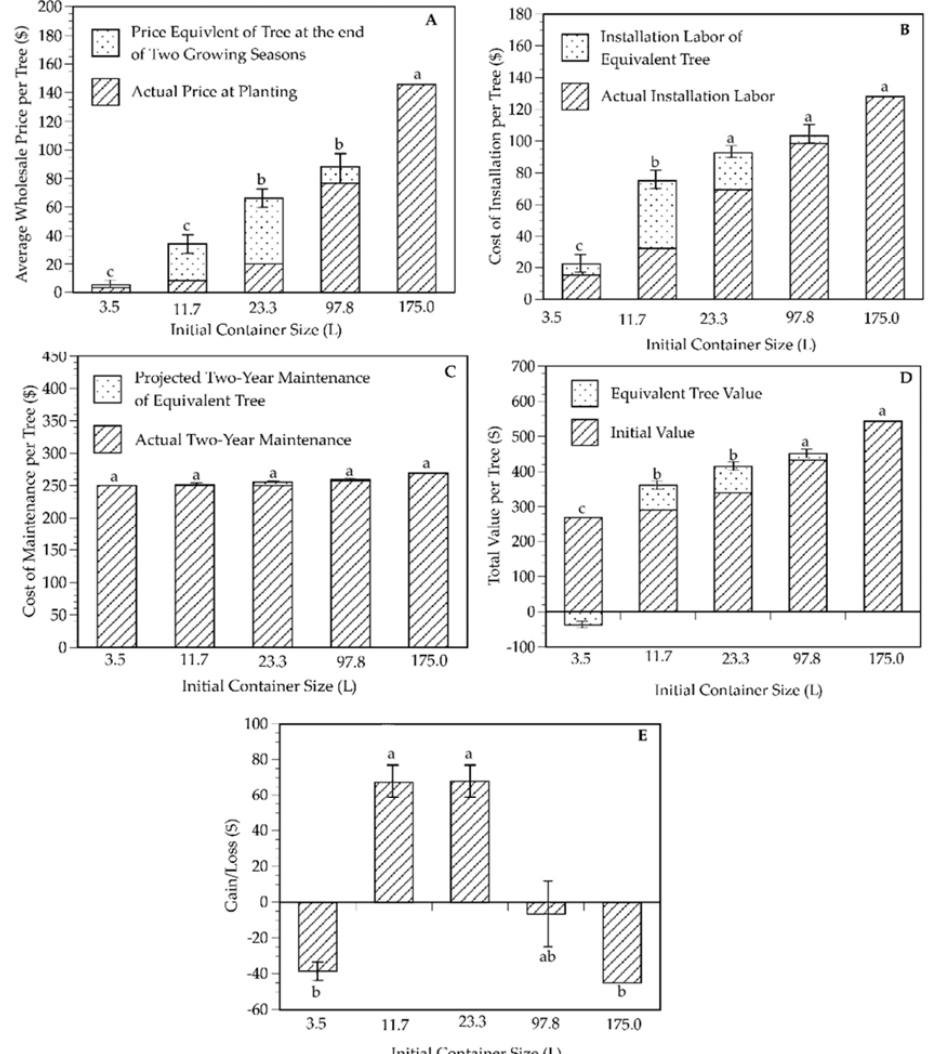
Figure 6. Mean (±standard error) wholesale cost ( A ), installation ( B ), maintenance cost ( C ), value ( D ), and gain or loss in dollars [US$] ( E ) of Taxodium distichum trees from transplant (diagonal hatching) to the end of the second growing season (stippled hatching) for initial container sizes of 3.5, 11.7, 23.3, 97.8 and 175.0 L trees. Means of final values after two growing seasons for initial container sizes with the same letter are not significantly different at p ≤ 0.05 using Student’s t